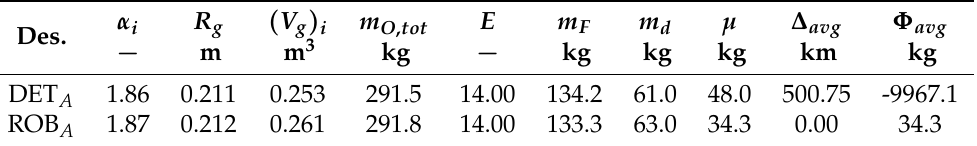
Table 11. Performance and design comparison: deterministic design A (DET A ) vs. robust design A (ROB A ) (800 km altitude). ∆ avg is the average altitude violation with respect to the target altitude, whereas Φ avg is the optimization merit